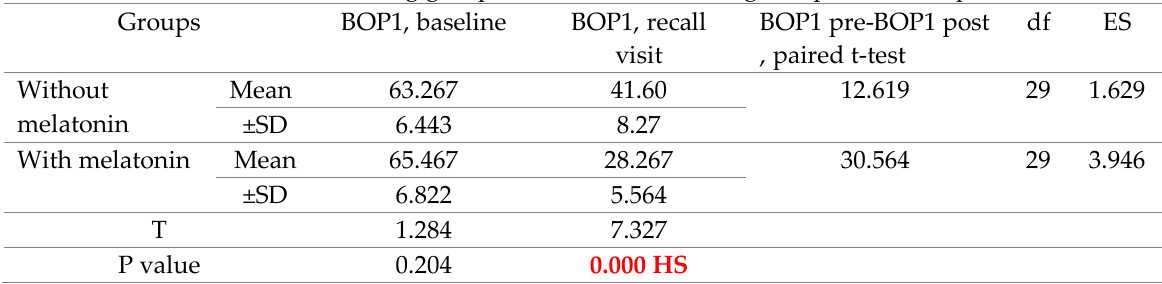
Table 3: Statistical test of BOP among groups and in each visit using independent sample T. Groups BOP1,